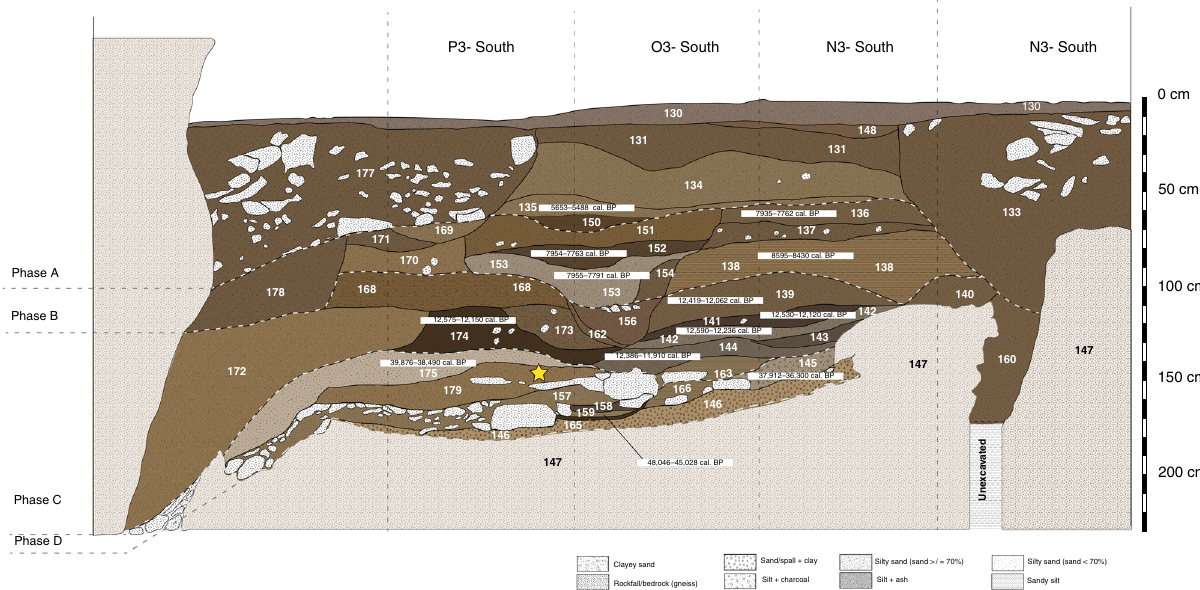
Fig. 2 Stratigraphy of Fa-Hien Lena. South wall, end of the 2010 excavation. The star indicates the approximate stratigraphic location 19 of the fossils described by Kennedy